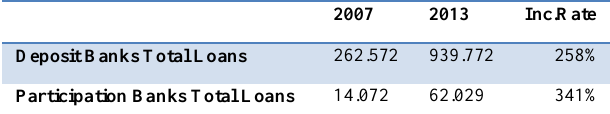
Table-11/a: Funds Utilized-Participation Banks and Deposit Banks In Turkey 2007-2013 (1000TL)